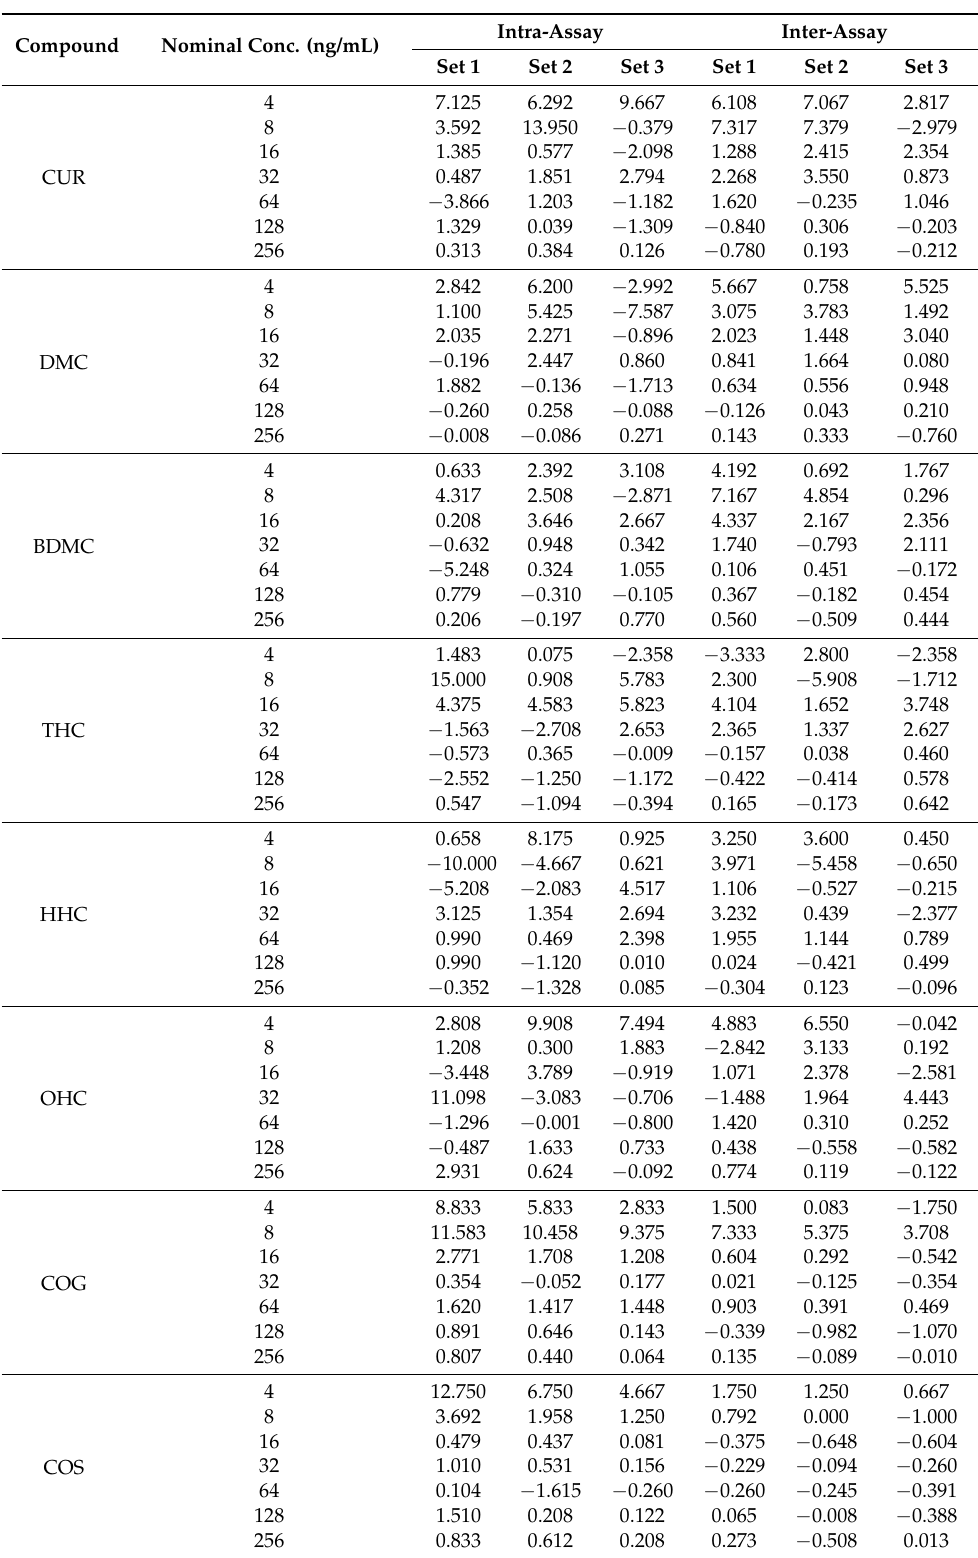
Table 2. Intra and inter day assay accuracy (% bias) data for CUR, DMC, BDMC, THC, HHC, OHC, COG and